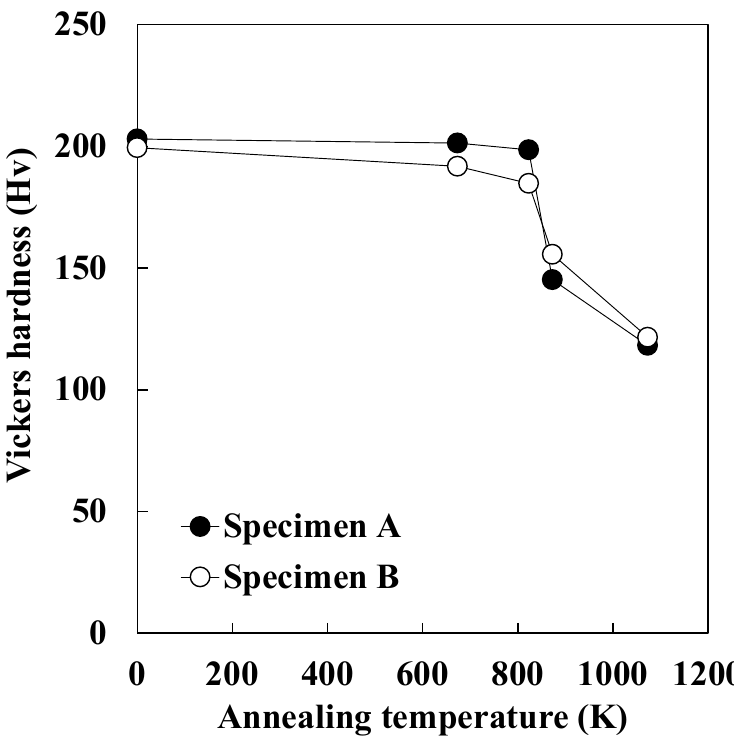
Figure 8. Changes in Vickers hardness during heating to 1073 K.